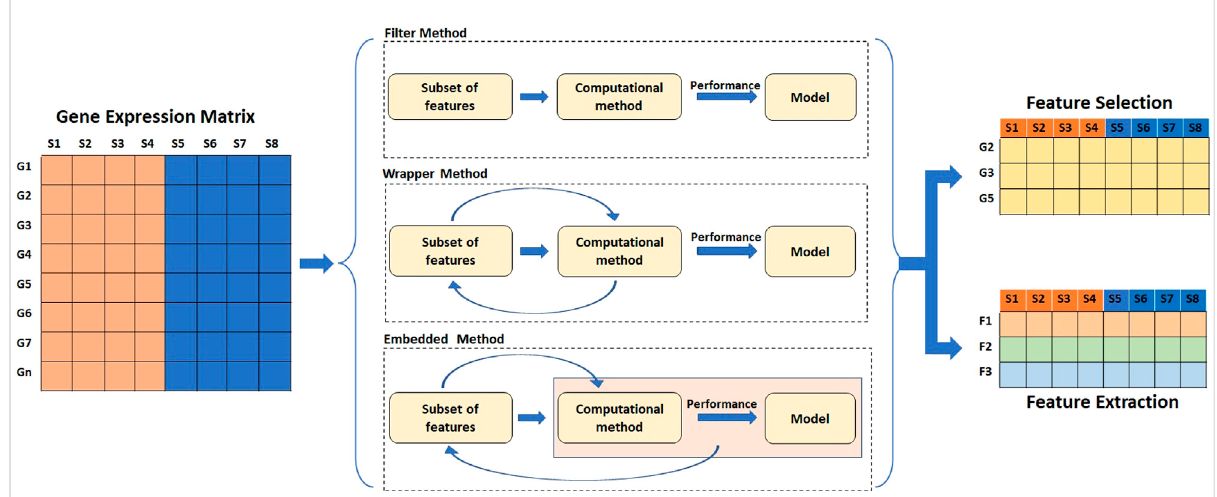
FIGURE 5 Methods of feature reduction. The fi lter methods of feature selection and extraction work independent of the performance of the learning algorithm. Feature wrapper methods select features based on the performance of the learning algorithm. Embedded methods perform feature selection as a part of learning